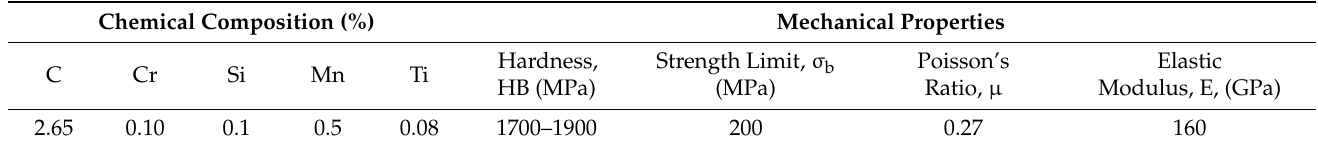
Table 1. Chemical composition and mechanical properties of gray cast iron EN-GJL-200 [46].